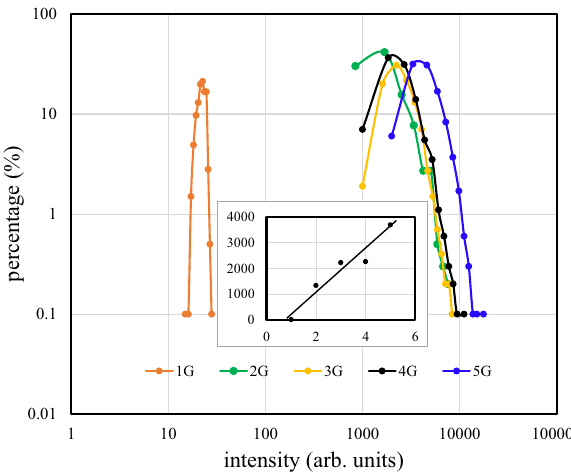
Figure 2. The percentages of G band intensities for mono-, bi-, tri-, tetra-, and penta-layer graphene/LiNbO 3 structures.